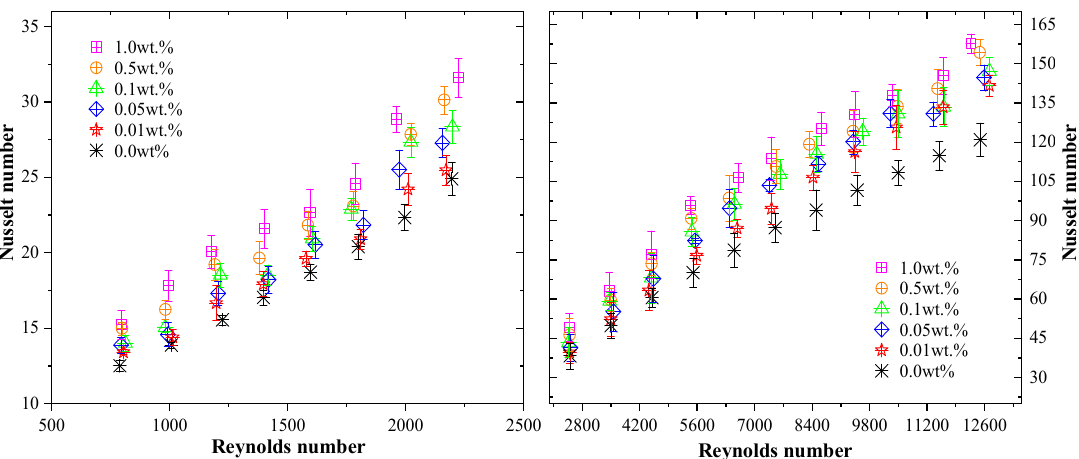
Figure 4. Effects of nanofluids mass fraction on Nusselt number in a laminar and turbulent flow.